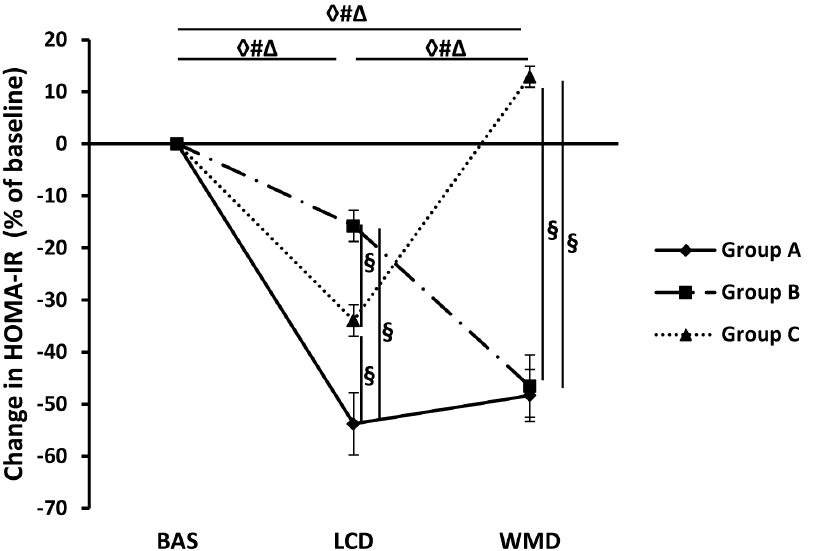
Figure 2. Clustering of insulin resistance profiles in obese individuals during the dietary intervention (n=216). Individual Homeostasis Model Assessment of Insulin Resistance (HOMA-IR) changes during an 8-week calorie restriction (LCD) and a 6-month weight maintenance diet (WMD) were clustered, resulting in 3 groups. The panel shows mean HOMA-IR changes expressed as change after LCD and at the end of the 6- montho weight maintenance (WMD) vs. baseline (BAS) values according to groups. The black line shows the HOMA-IR profile for group A (n=94). The dashed line shows the HOMA-IR profile for group B (n=48). The dotted line shows the HOMA-IR profile for group C (n=74). The A, B, and C are the mean of HOMA-IR changes in each clustered group. e : p , 0.05, data different in group A. D : p , 0.05, data different in group B. # : p , 0.05, data different in group C. 1 : p , 0.05, data difference between groups. Values are means 6 SEM.